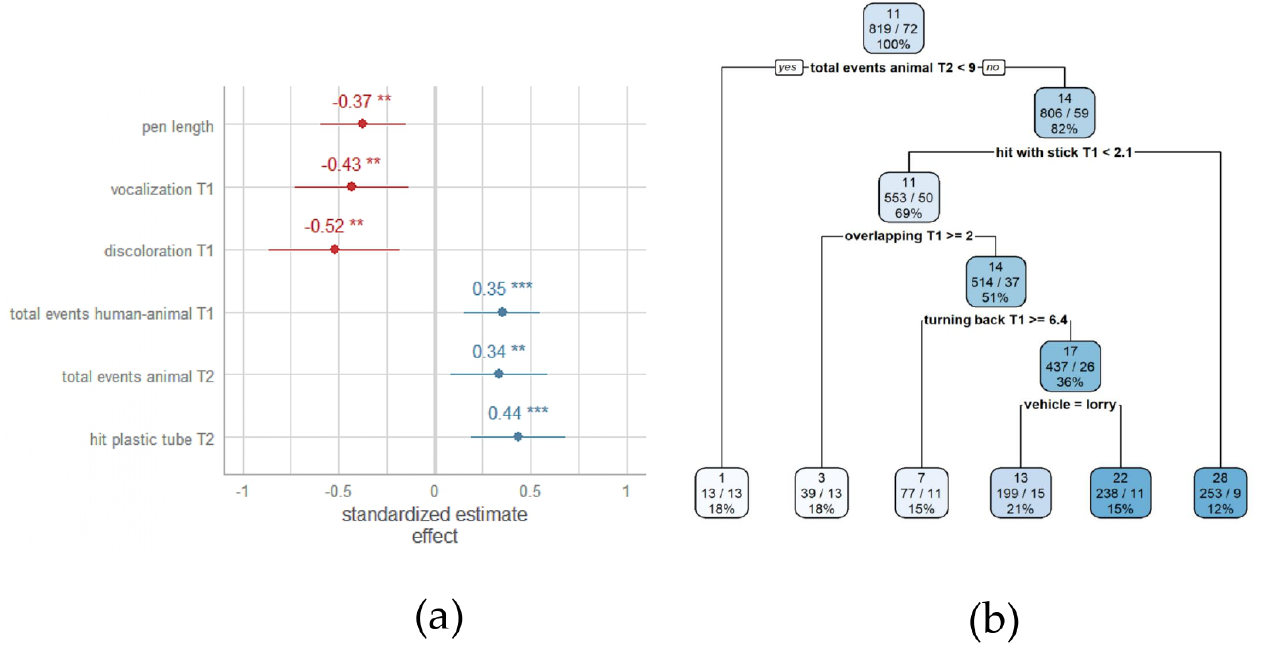
Figure 3. Association between pre-slaughter conditions and severe lesions in the middle region of heavy pig carcasses: ( a ) forest plot and ( b ) regression tree plot. In forest plot ( a ), ** stands for p < 0.01, and *** for p <